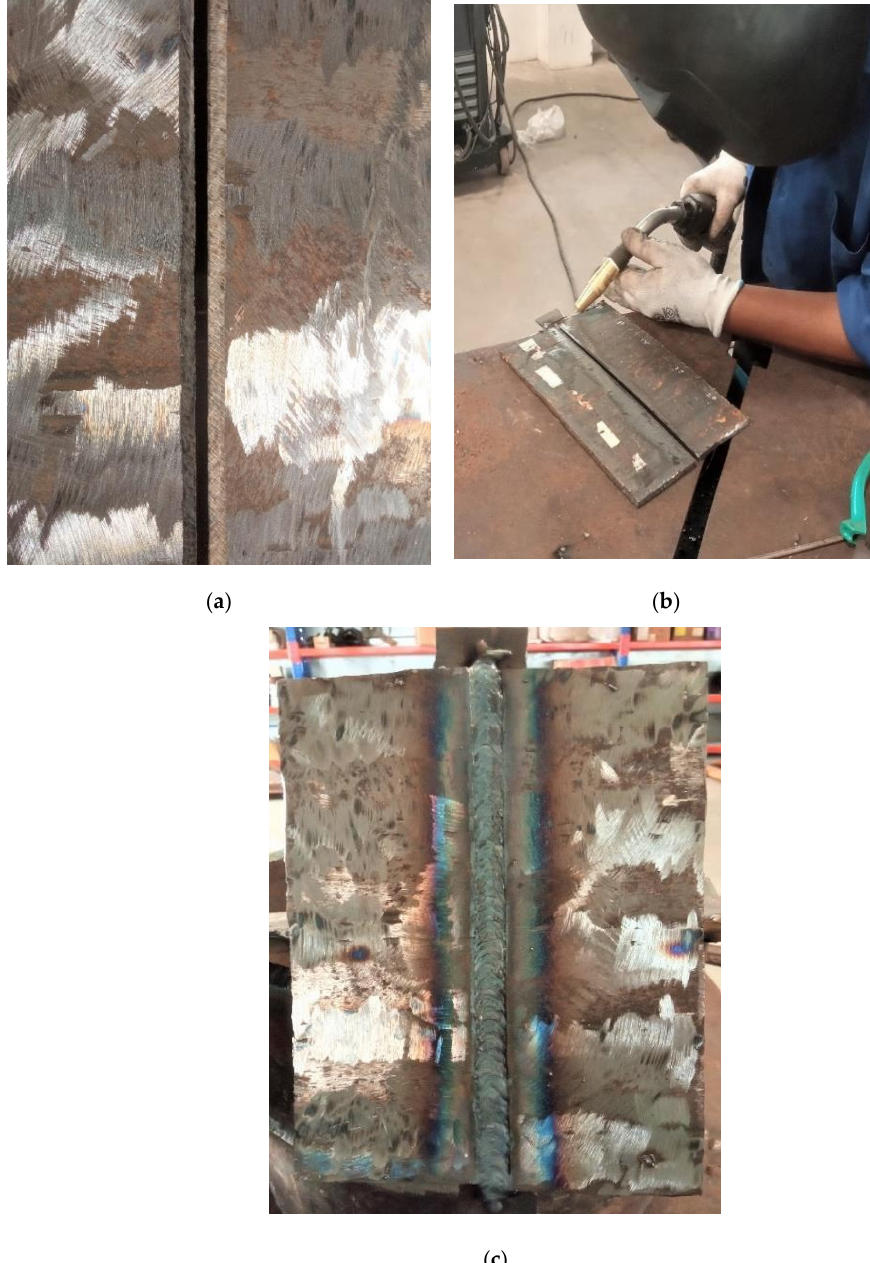
Figure 3. Grooving, tacking, and welding of steel plates. ( a ). groove. ( b ). tack. ( c ). welded plates. Table 2. Particulars of experimental settings during welding.